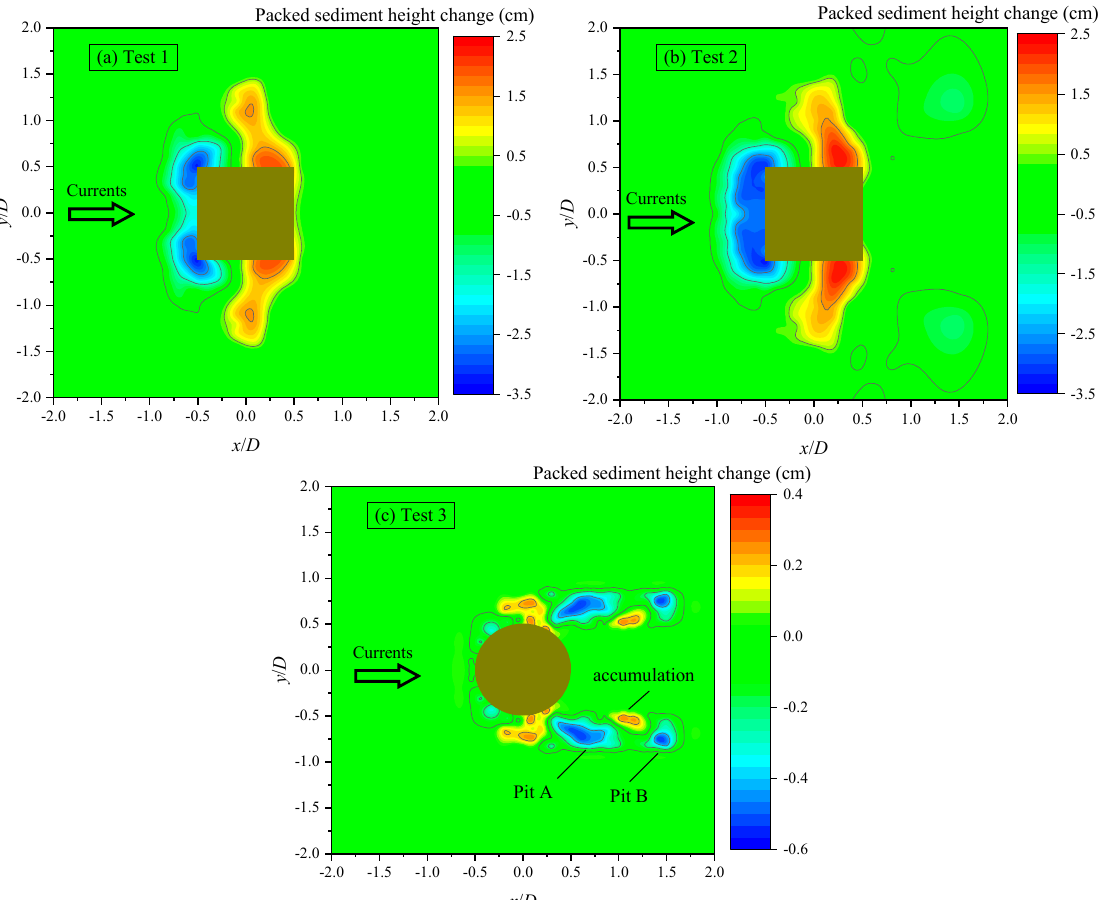
Figure 8. Scour depths close to the CC pile (test 3). ( a ) On a circle with a diameter of 10.4 cm; ( b ) On a circle with a diameter of 11 cm.